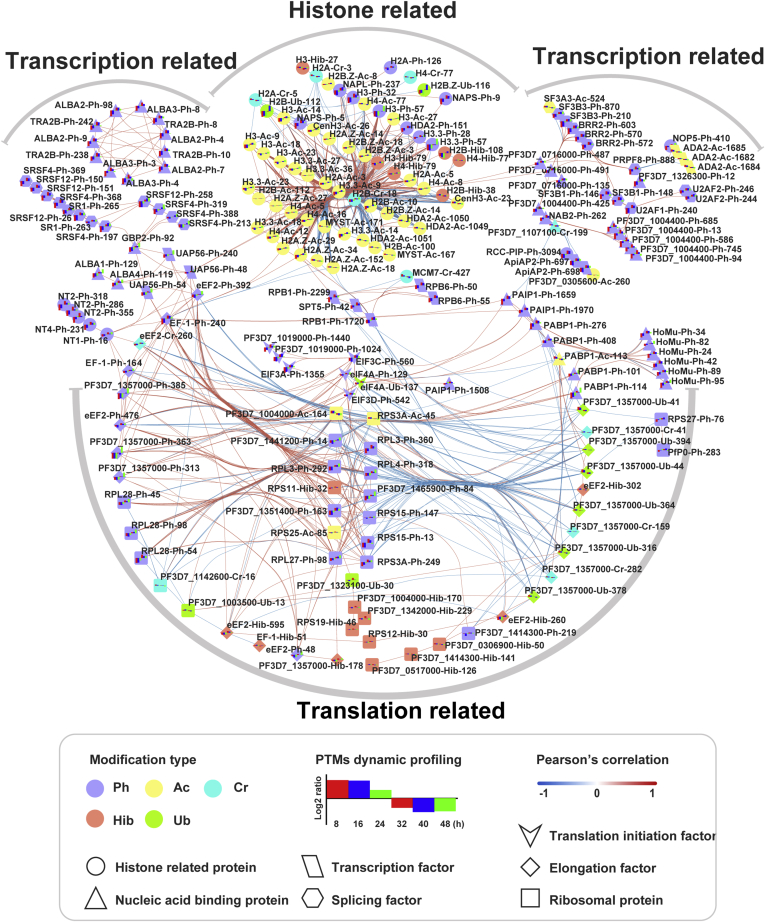
Networks of modified proteins associated with gene regulation and expression. Histone-related proteins are shown in the middle of the top area. The left and right sides are transcription-related proteins, including the transcription factors, splicing factors, and elongation factors. The elliptical region below indicates translation-related proteins, including the translation factors and ribosomal proteins in the middle and the elongation factors on both sides. Small triangles represent nucleic acid-binding proteins distributed in multiple regions. The colors of the lines indicate Pearson's correlation (Pearson's correlation > 0.9). The red line represents a positive correlation, and the blue line represents a negative correlation. Modification type and PTMs dynamic profiling are shown in the figure. PTMs, posttranslational modifications.